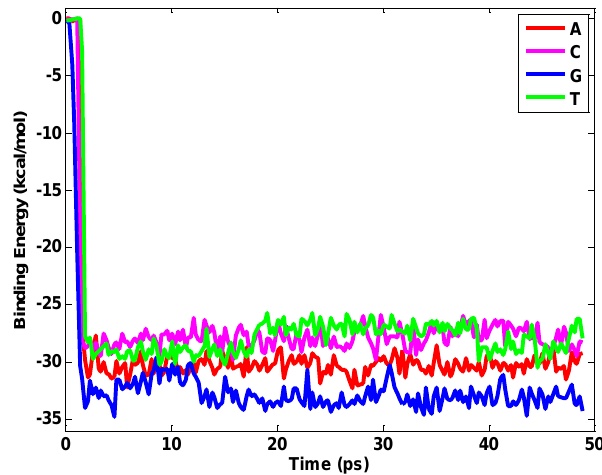
Figure 3 . Evolution of binding energy between graphene and four basic nucleotides.